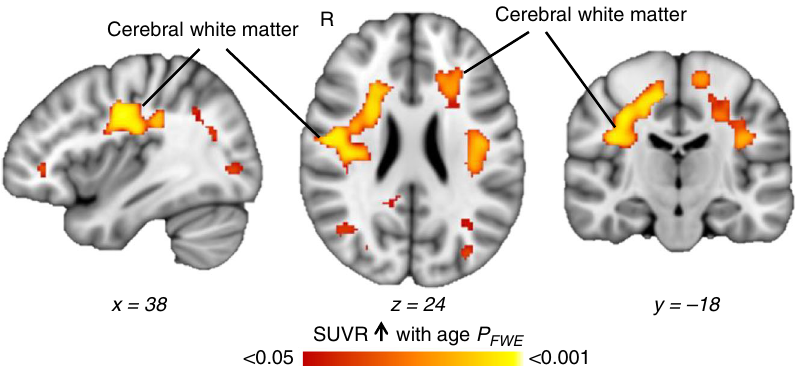
Fig. 1 [ 11 C]Martinostat uptake increases with age in the white matter. Voxel-wise correlations of SUVR with age, controlled for sex, total grey matter volume/intracranial volume, white matter volume/intracranial volume, and cerebrospinal fl uid volume/intracranial volume ( n = 41). Statistical maps were overlaid onto the MNI 1 mm template in radiological orientation (family wise error rate (FWE) corrected for multiple comparisons, P FWE < 0.05; non- parametric permutation testing n = 10,000 permutations). Red – yellow represents regions signi fi cantly increased